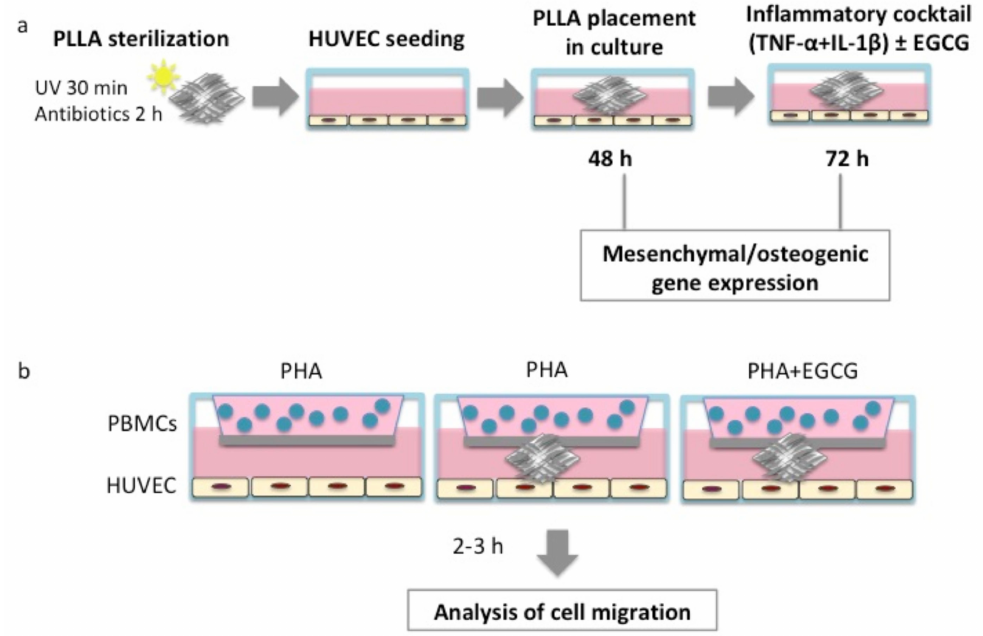
Figure 1. Workflow followed for PLLA/HUVEC co-culture. ( a ) PLLA slices were sterilized under UV lights for 30 min and treated with 2% antibiotics for 2 h. Then, PLLA slices were placed in the well covered by growth medium, after HUVEC attachment to the well plates. After 48 h, cells were processed for (1) gene expression, (2) EGCG testing under inflammatory conditions for 72 h, followed by gene expression analysis. ( b ) Experimental scheme of PBMCs/HUVEC co-culture in a transwell system: (1) PBMCs activated with PHA in the upper chamber and HUVEC in the lower chamber (PBMCs + PHA/HUVEC); (2) PBMCs activated with PHA in the upper chamber, HUVEC and PLLA in the lower chamber (PBMCs + PHA/HUVEC+PLLA); PBMCs activated with PHA and treated with EGCG (25 µ M) in the upper chamber, HUVEC and PLLA in the lower chamber (PBMCs + PHA + EGCG/HUVEC + PLLA). After 2 h and 3 h, transwell filters were processed for the analysis of PBMC migration. EGCG: epigallo-catechin-3-gallate; HUVEC: human umbilical vein endothelial cells; PBMCs: peripheral blood mononuclear cells; PHA: phytohaemagglutinin; PLLA: poly-L-lactic acid; UV: